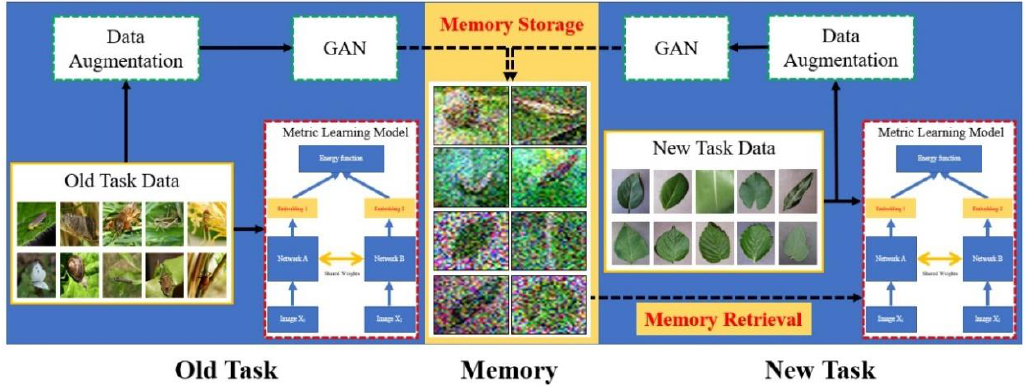
Figure 7. The workflow of continual metric learning.